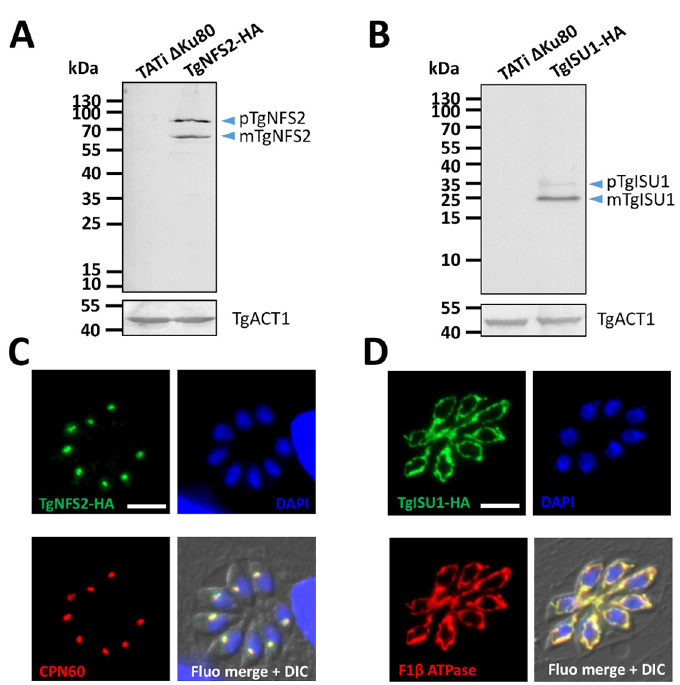
Fig 2. TgNFS2 and TgISU1 localize to the apicoplast and the mitochondrion, respectively. Detection by immunoblot of C-terminally HA-tagged TgNFS2 (A) and TgISU1 (B) in parasite extracts reveals the presence of both precusor (p) and mature (m) forms of the proteins. Anti-actin (TgACT1) antibody was used as a loading control. Immunofluorescence assay shows TgNFS2 co-localizes with apicoplast marker TgCPN60 (C) and TgISU1 co-localizes with mitochondrial marker F1 β ATPase (D). Scale bar represents 5 μ m. DNA was labelled with DAPI. DIC: differential interference contrast.